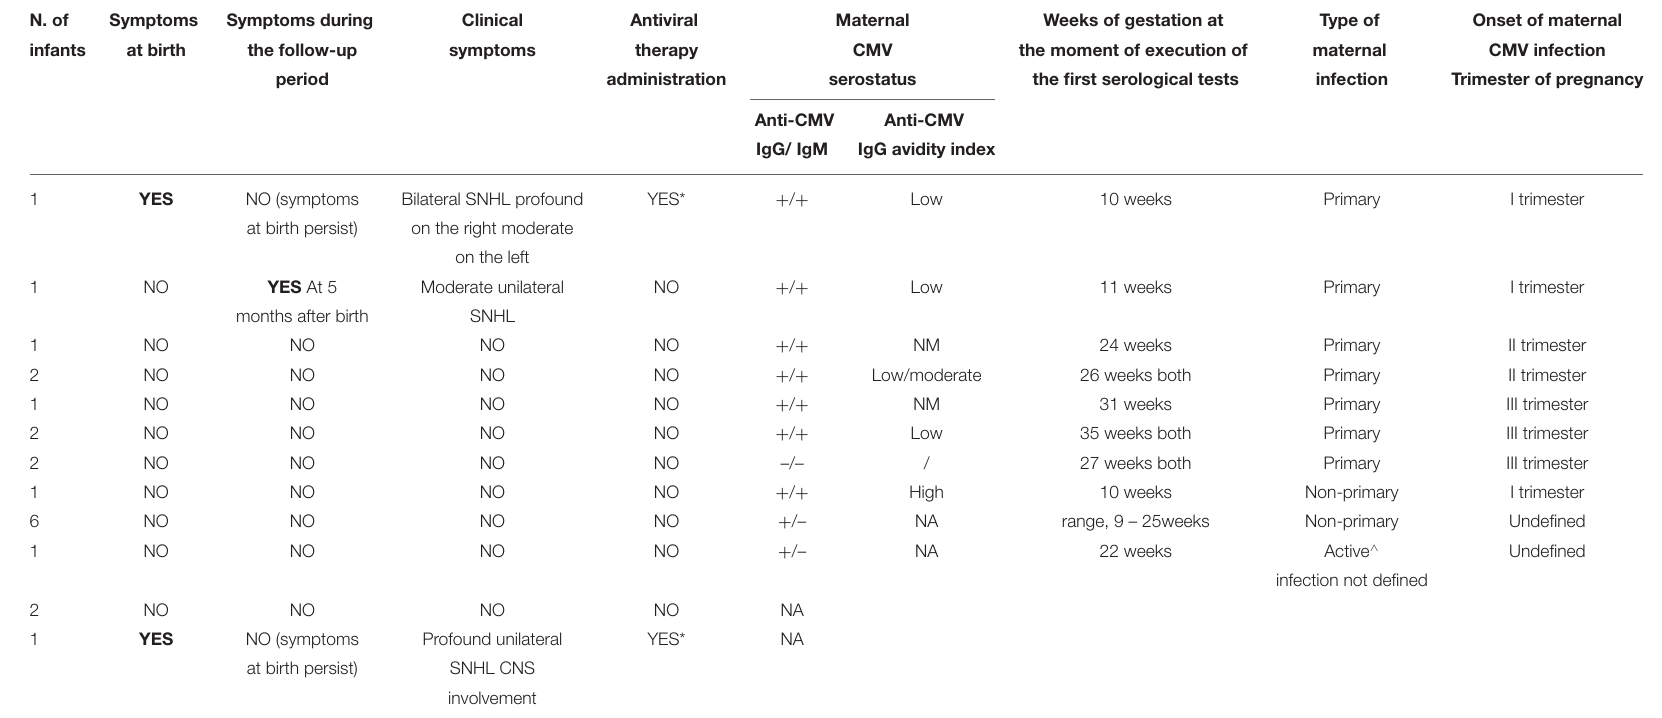
TABLE 2 | Characteristics of the 21 neonates with cCMV infection: symptoms, antiviral therapy, and maternal CMV infection. N.